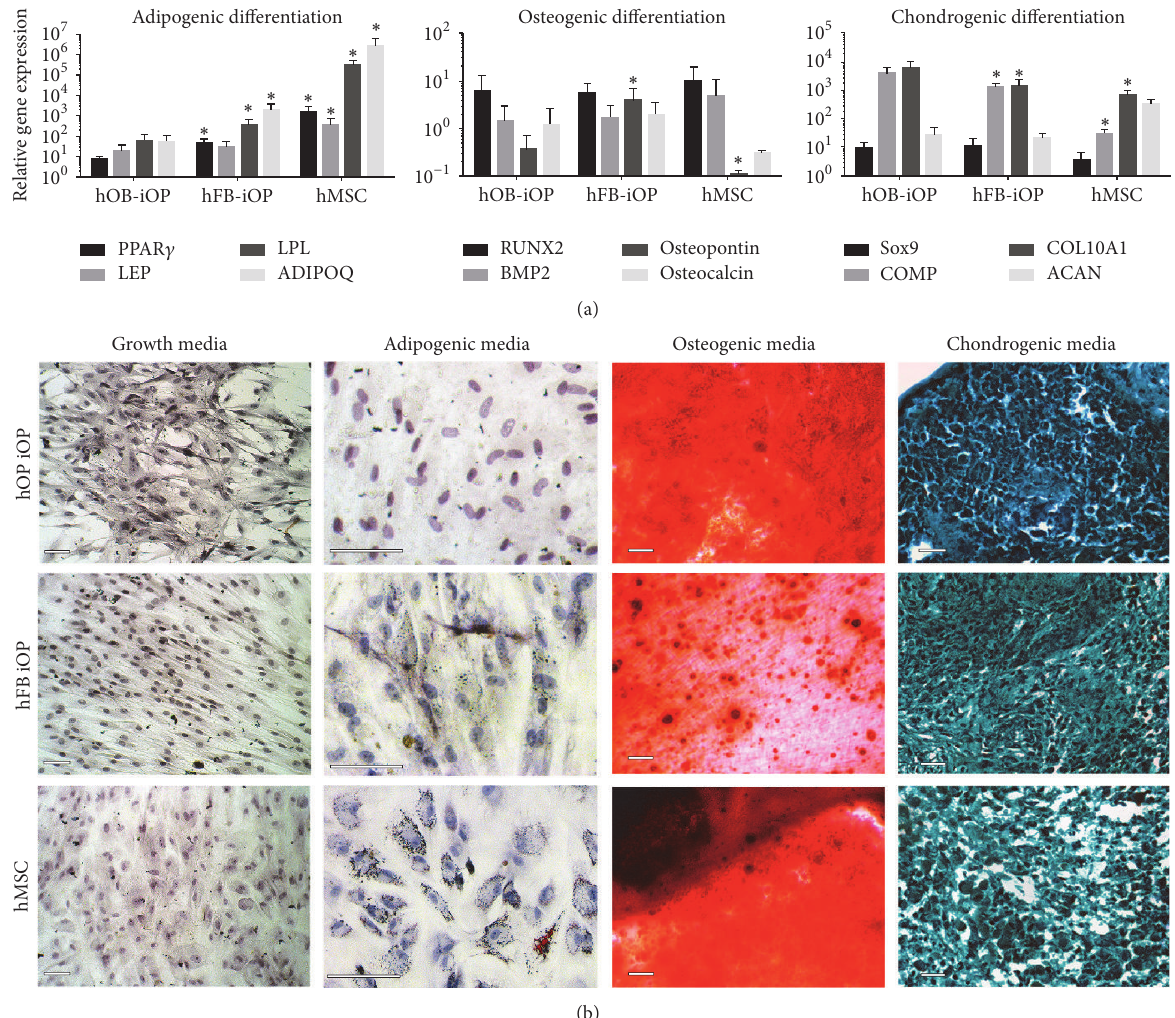
Figure 5: iOP differentiation to adipocytes, chondrocytes, and osteoblasts. (a) Gene expression of adipocyte, chondrocyte, and osteoblast markers normalized to their respective growth media control cells expression levels. Adipogenic expression levels were lower than both hFB- iOP and hMSC indicating a lack of adipogenic capacity ∗ Significantly different from hOB-iOP differentiated cells ( 𝑃 < 0.05 ). (b) Alizarin Red S, Oil Red O, and Alcian blue staining of adipogenic, osteogenic, and chondrogenic differentiations with a hematoxylin counterstain demonstrated comparable chondrogenic and osteogenic differentiation capacity, with a lack of hOB-iOP adipogenesis. Scale bars = 30 𝜇